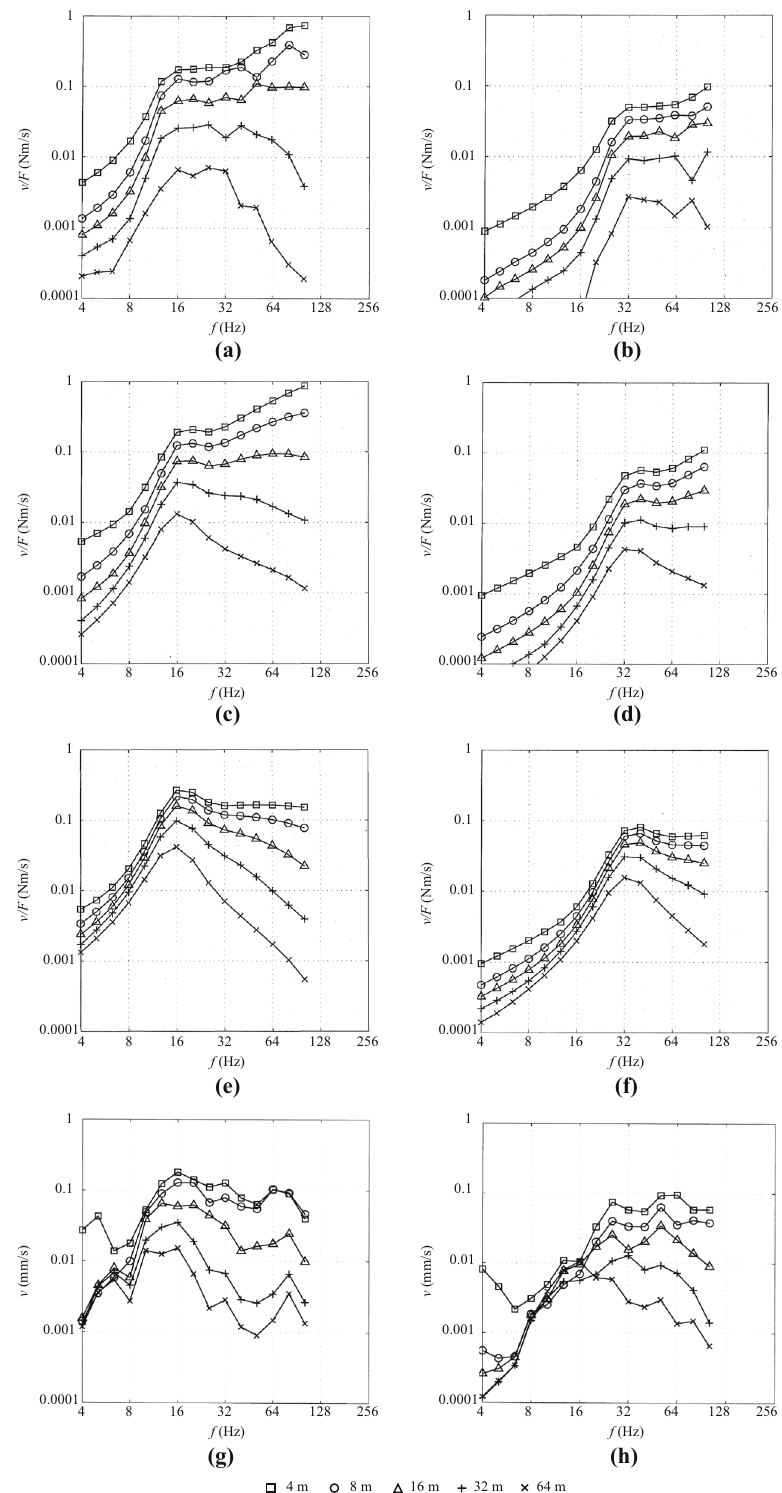
Fig. 7 Ground vibration at a soft layered site ( a , c , e , g ) and at a stiff layered site ( b , d , f , h ) at different distances: a , b exact point-load transfer functions; c , d approximated point-load transfer functions; e , f train-load transfer functions; g , h measured train-induced ground